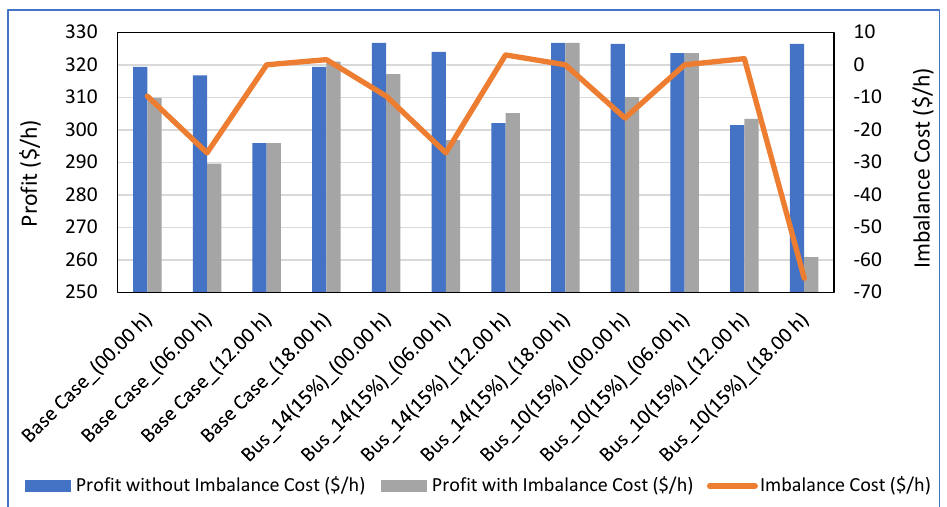
Figure 9. Profit Comparison with Imbalance Cost (Kolhapur). Case 4: Solar PV-Battery Operation with SQP, ABC, and AGTO (Modified IEEE 14-bus System)